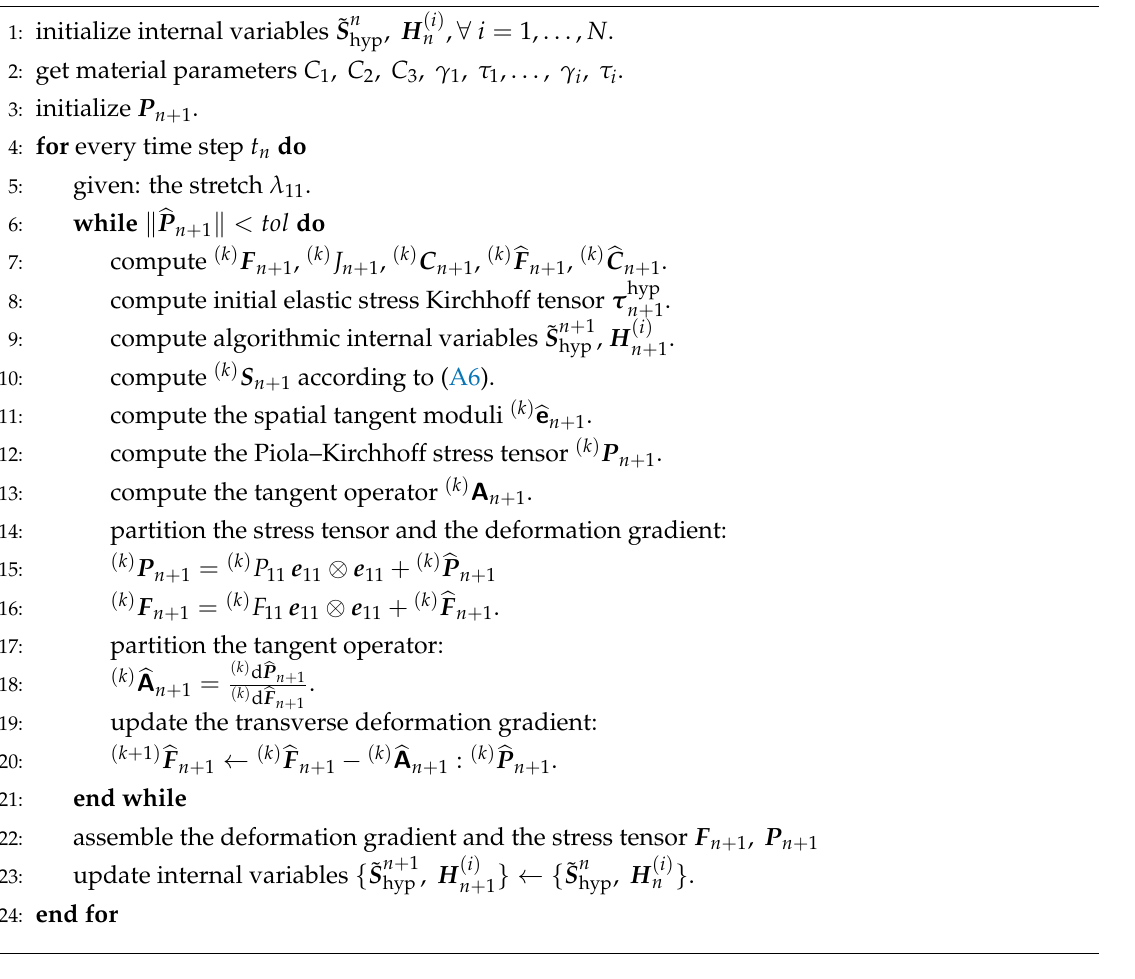
Algorithm 1 Strain-driven constitutive driver (relaxation)—uni-axial stress state; see also Appendix A.